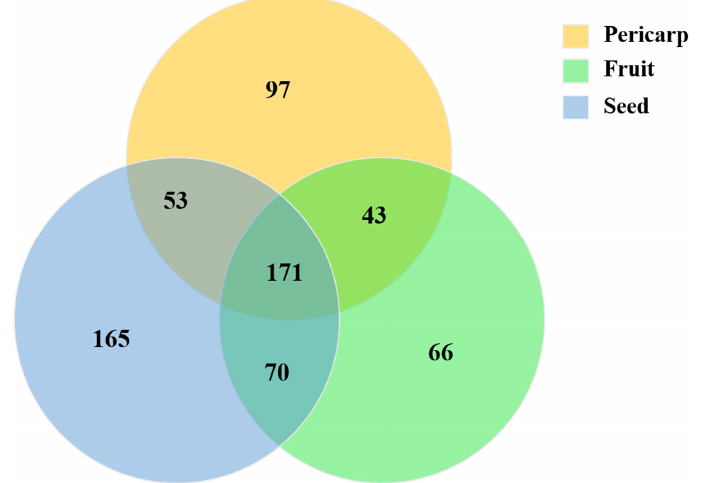
Figure 2. Venn diagram showing the main secondary metabolites (alkaloids, lignans and neolignans, lipids and lipid-like molecules, phenylpropanoids, and polyketides) among the fruit, peri- carp, and seed. Table 1. Triterpenoid compounds identified in the fruit, pericarp, and seed of A. trifoliata (UHPLC- TOF-MS/MS) and metabolomic pathways. Identified Metabolites